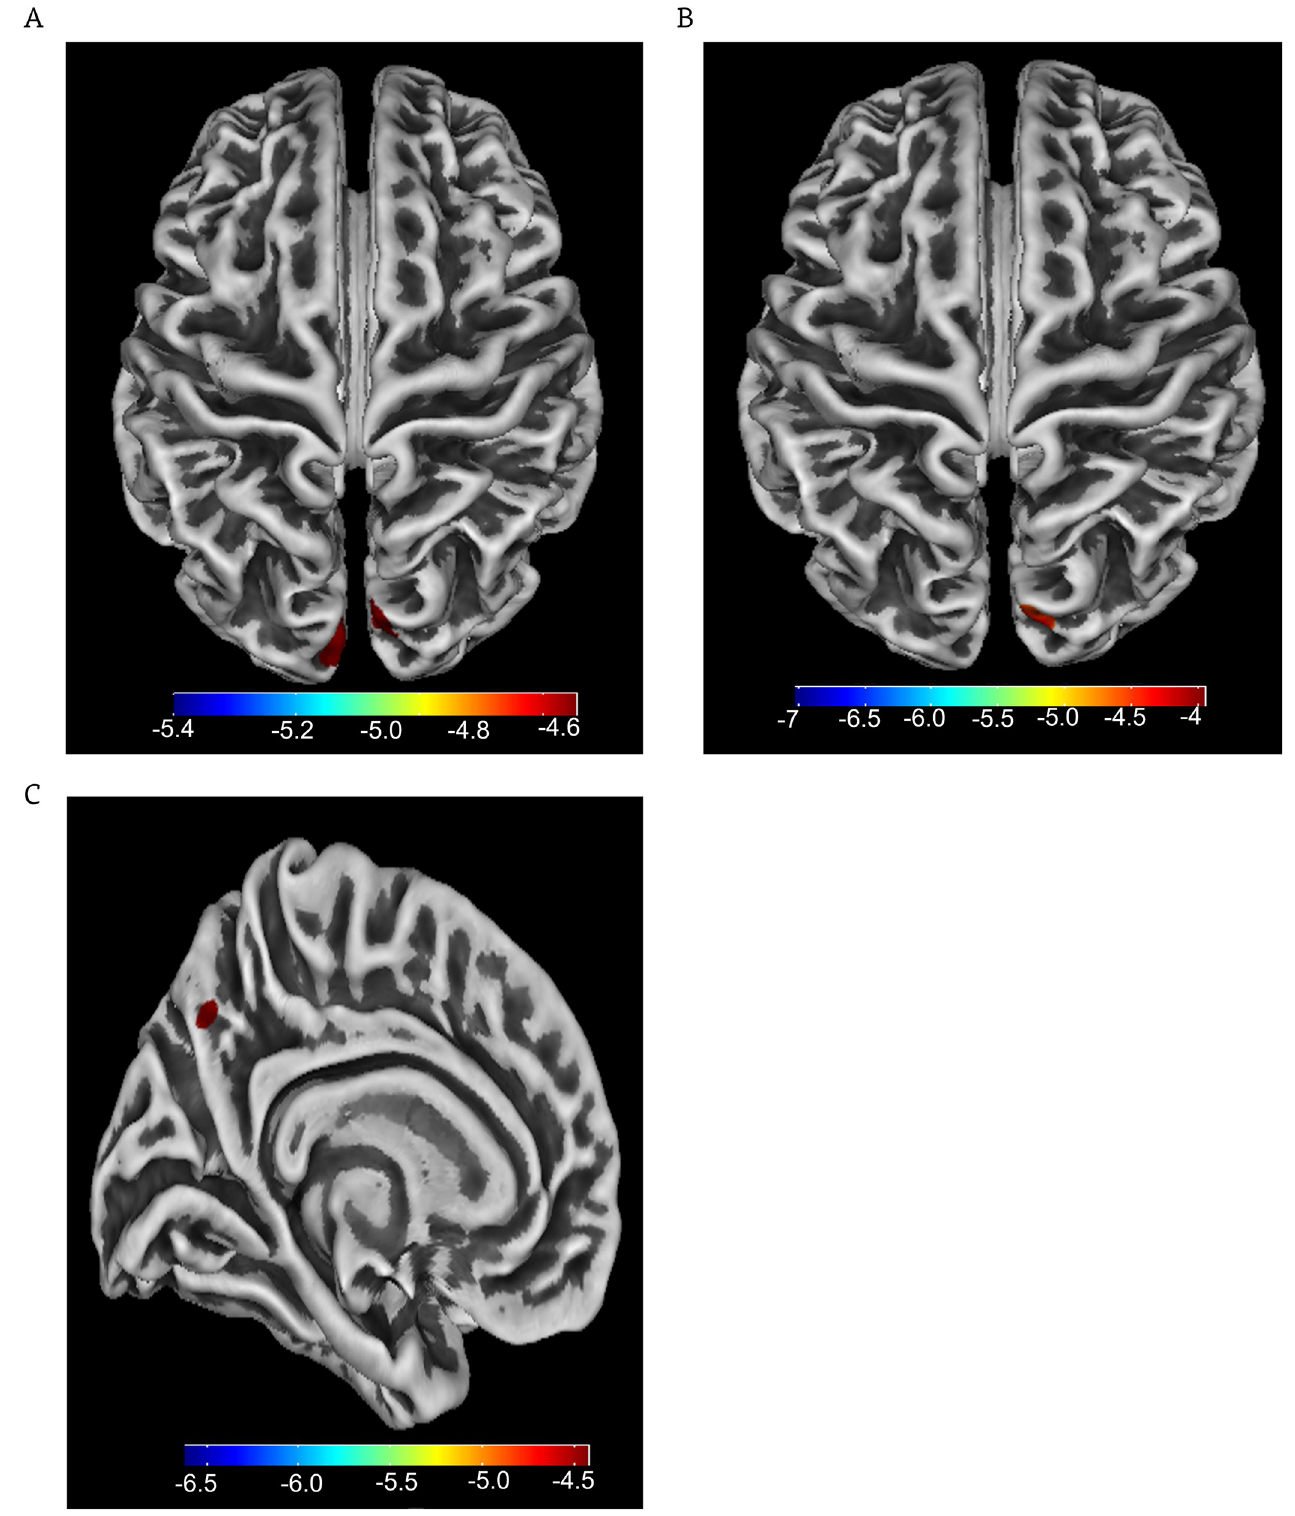
Fig 2. (A) Cortical thickness differences of PD patients with MCI and healthy controls; (B) Cortical thickness differences of PD patients without MCI and healthy controls; (C) Cortical thickness differences of PD patients with MCI and PD patients without MCI. The scale bar shows t values, FDR correction, P < 0.05, size >